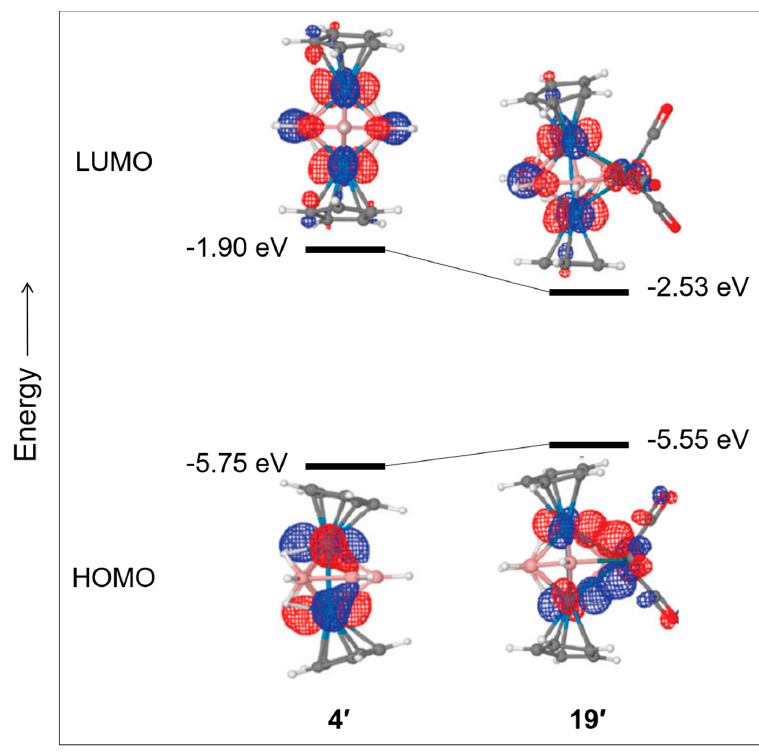
Figure 5. HOMO and LUMO plots of 4’ and 19’ Adapted from Ref. [74].